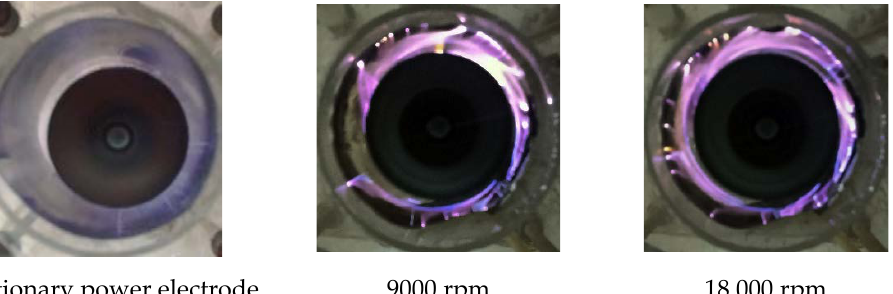
Figure 3. Photographs of the discharge in the reactor for the stationary power electrode and the rotational frequencies of 9000 and 18,000 rpm at 14 kV applied voltage (photographs for other rotational frequencies are shown in Figure S3 of the Supplementary Materials).